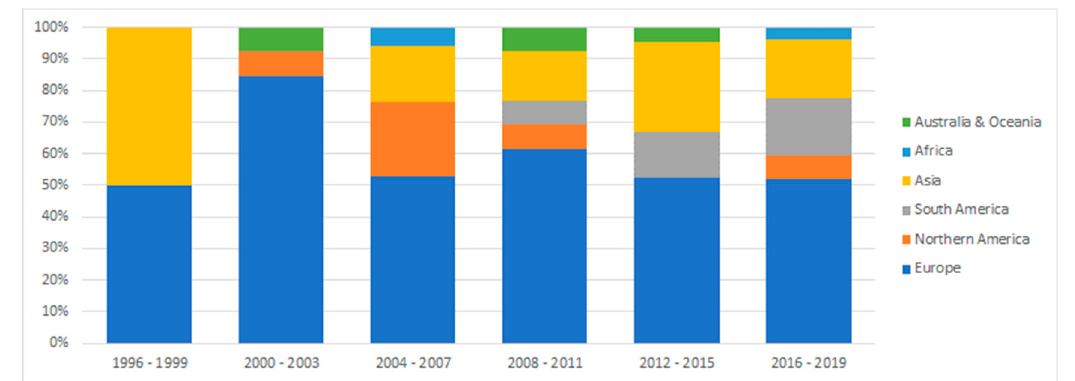
Figure 3. Region of study.